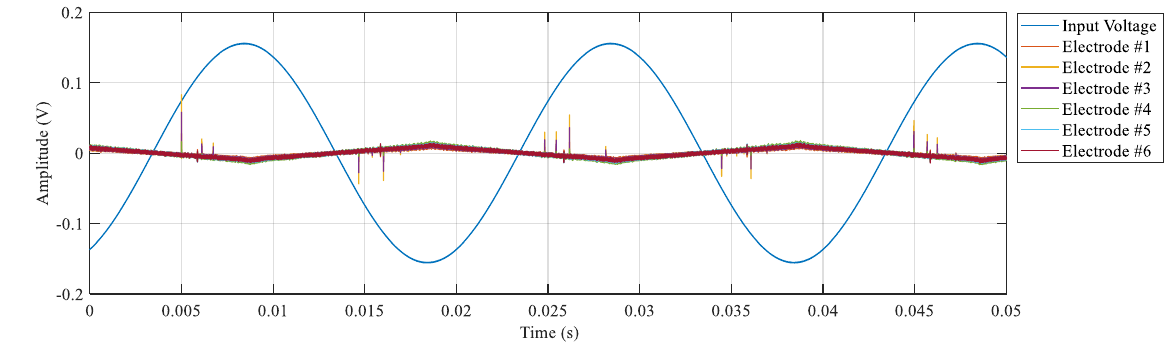
Figure 10. Measured voltage from the monitor and the electrodes, joint #2.